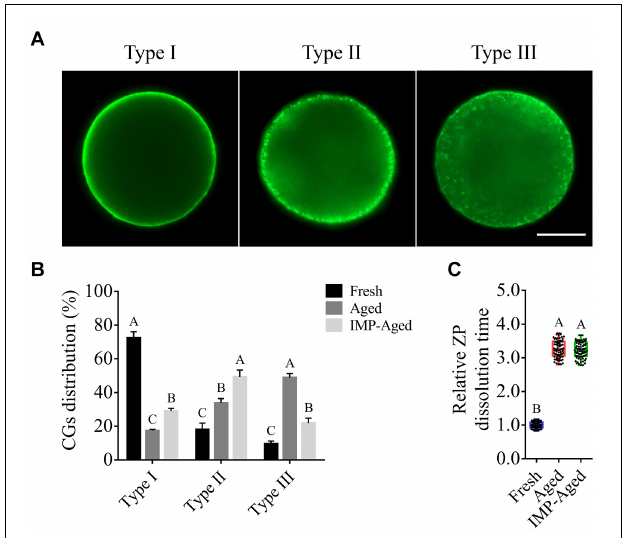
FIGURE 2 | Effects of IMP on the distribution of cortical granule and ZP hardness in aged oocytes with/without IMP treatment. (A) Representative images of different types of cortical granule distribution. Scale bar = 25 µ m. (B) The proportion of different types of oocytes in the fresh ( N = 105), aged ( N = 98), and IMP-treated aged groups ( N = 100). R = 3. Significant differences are represented by different capital letters ( P < 0.01). (C) Relative dissolution time of ZP in fresh ( N = 75), aged ( N = 75), and IMP-treated aged ( N = 75) oocytes. No significant difference was observed in dissolution time of ZP between aged and IMP-treated aged oocytes, which suggested no significant difference in ZP hardness with or without IMP treatment. R = 3. Significant differences are represented by different capital letters ( P <